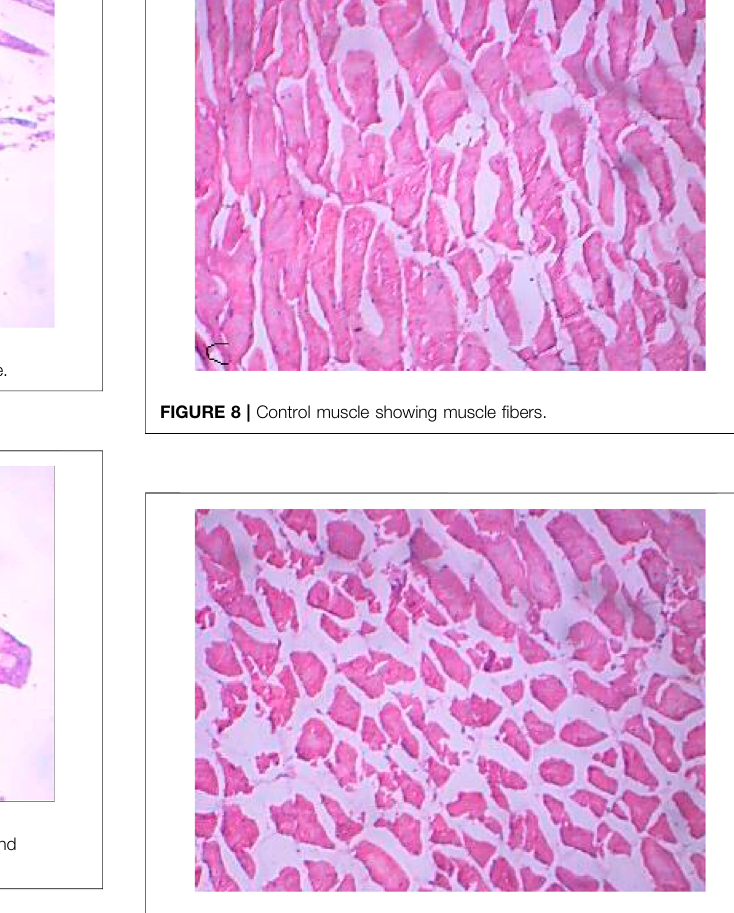
FIGURE 9 | Treated muscle section showing splitting fi ber and variation in myo fi ber